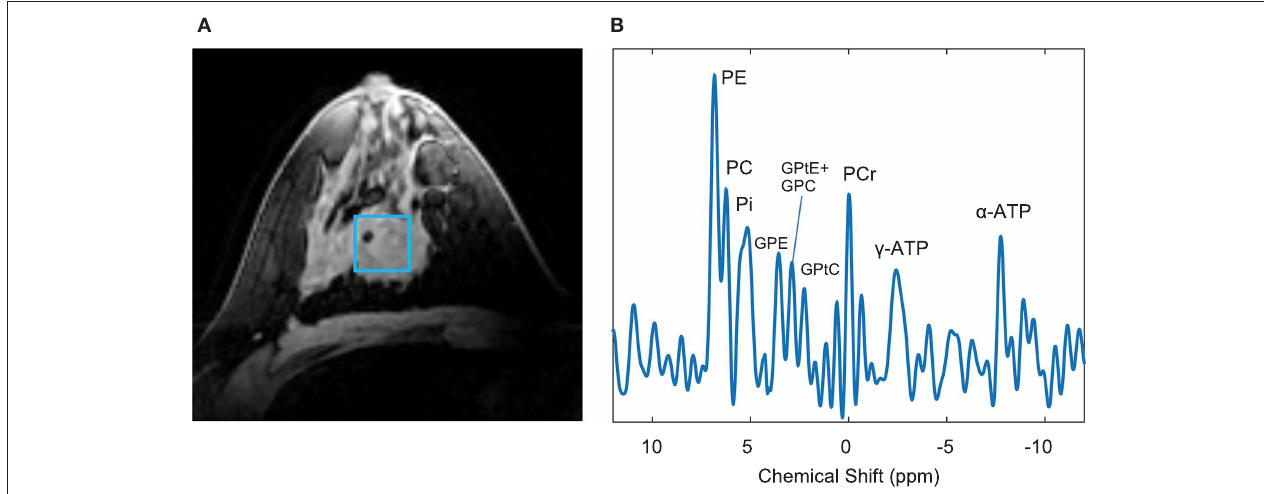
FIGURE 4 | Example 7T data of a patient with an ER + , PR + , HER2- tumor. (A) T 1 -weighted image with indicated voxel selection (blue square), (B) 31 P MRS spectrum of nine fitted metabolites. Adapted from Krikken et al. (88), used under CC